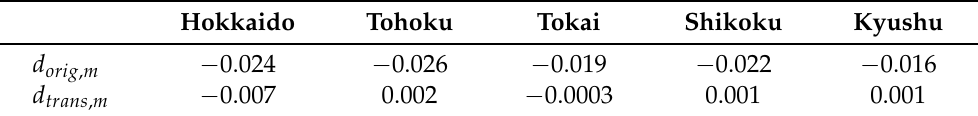
Table 2. Mean of the averaged AHI or the transformed AHI minus MODIS NDVIs for the five sites ( d orig , m and d trans , m